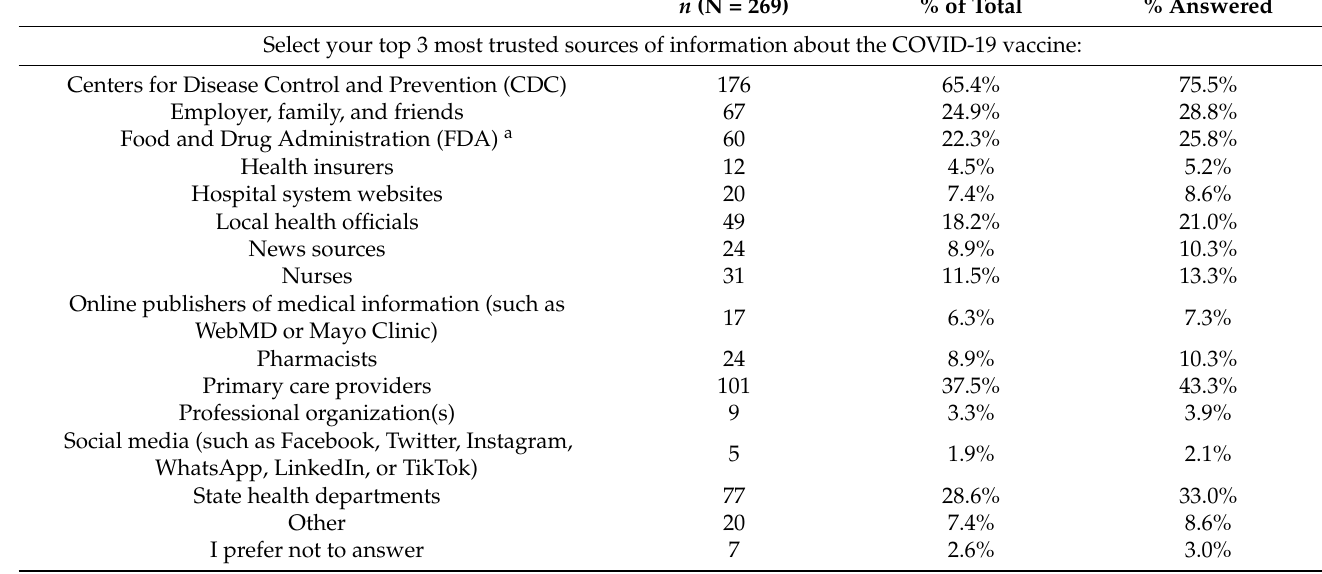
Table 1. Frequency counts for identified trusted sources of information about the COVID-19 vaccine overall among the NJ secondary or high school teachers based on survey responses received. n (N = 269) % of